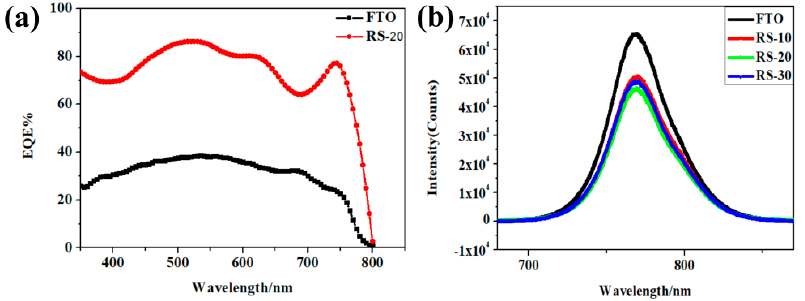
Figure 6. ( a ) External quantum efficiency (EQE) curves of different planar PSCs and ( b ) the corresponding photoluminescence spectra of the samples.